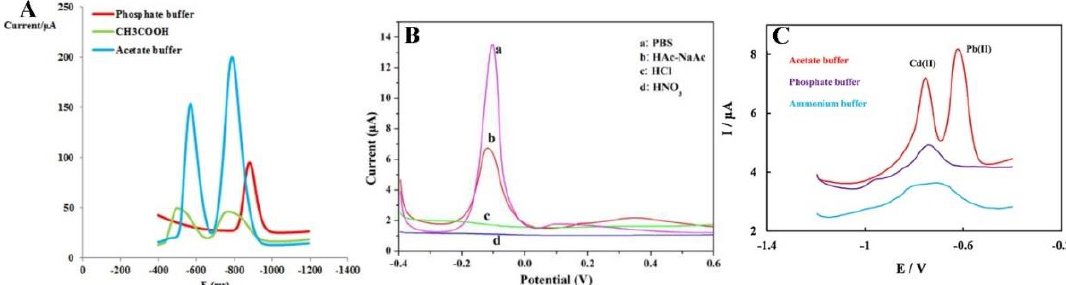
Figure 6. Electrolyte selection in determination of Pb 2+ and Cu 2+ , by Dahaghin et al. [66] ( A ), Pb 2+ by Wei et al. [55] ( B ), and Cd 2+ and Pb 2+ detection by Bagahayeri et al. [69] ( C ). All Figures are adapted from references [55,66,69] with permission from Elsevier.